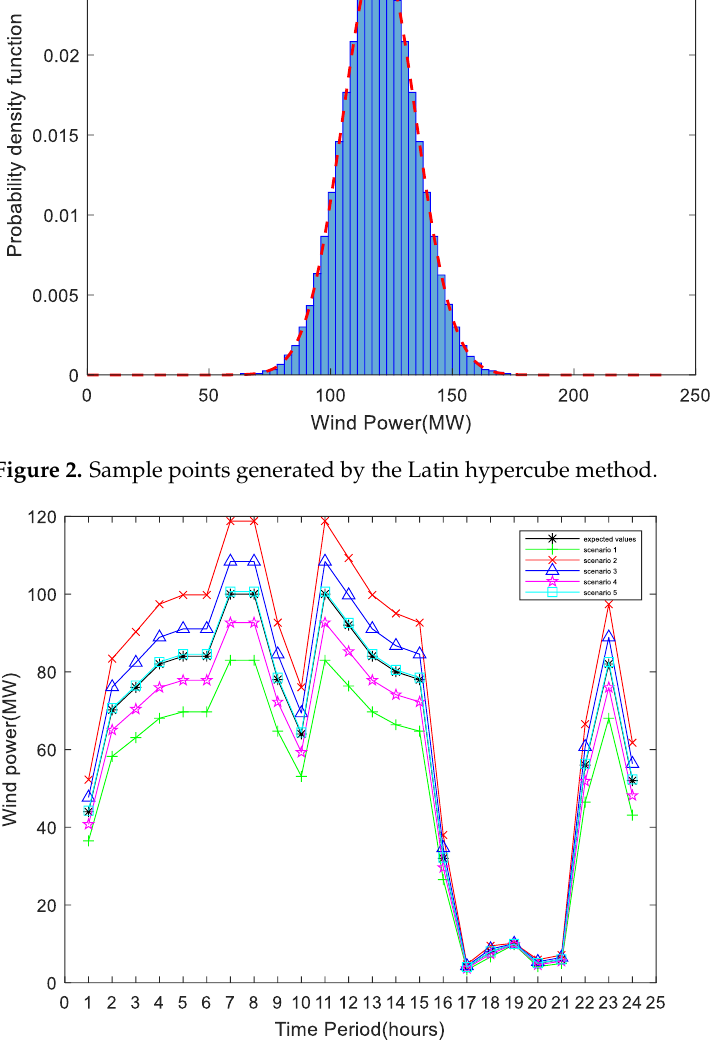
Figure 3. Specific wind power outputs for five types of scenarios.